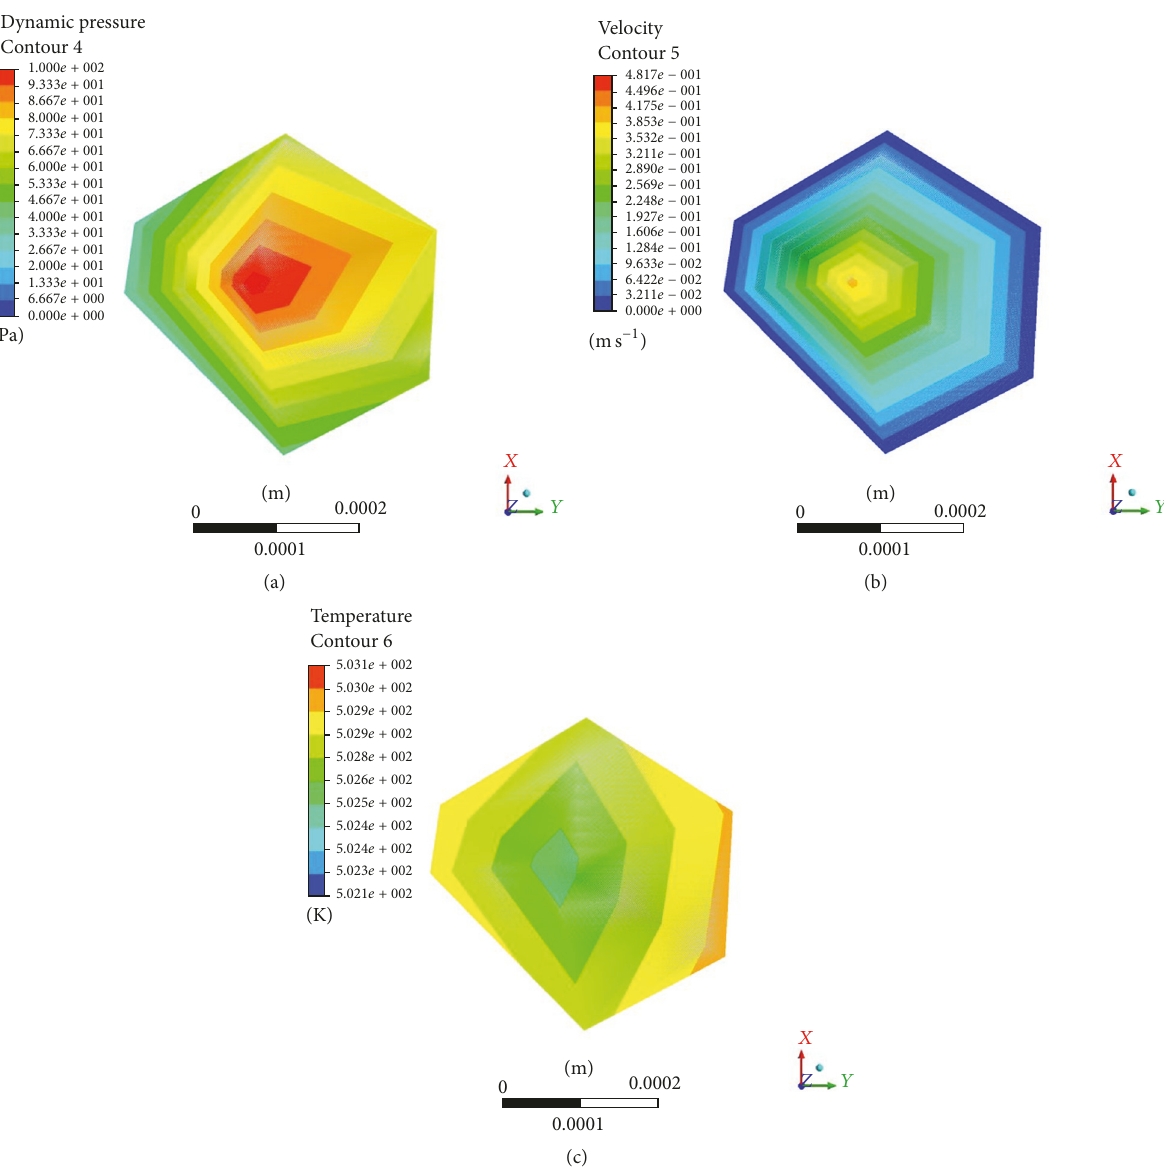
Figure 13: Contours of cross section at nozzle: (a) pressure contours; (b) velocity contours; (c) temperature